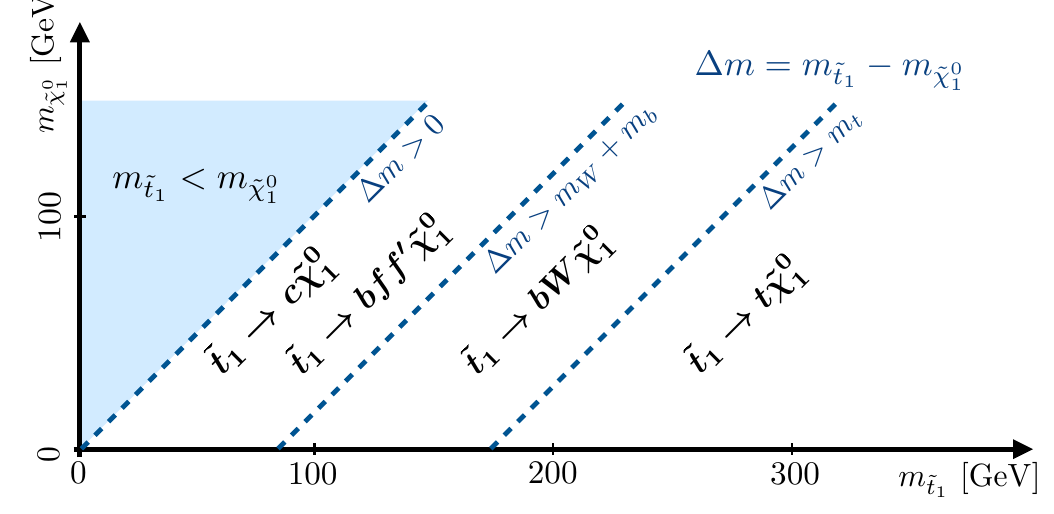
Figure 3 . Illustration of the preferred stop decay modes in the plane spanned by the masses of the stop (~ t ) and the lightest neutralino (~ (cid:31) 0 1 ), where the latter is assumed to be the lightest supersym- 1 metric particle. Stop decays into supersymmetric particles other than the lightest supersymmetric particle are not